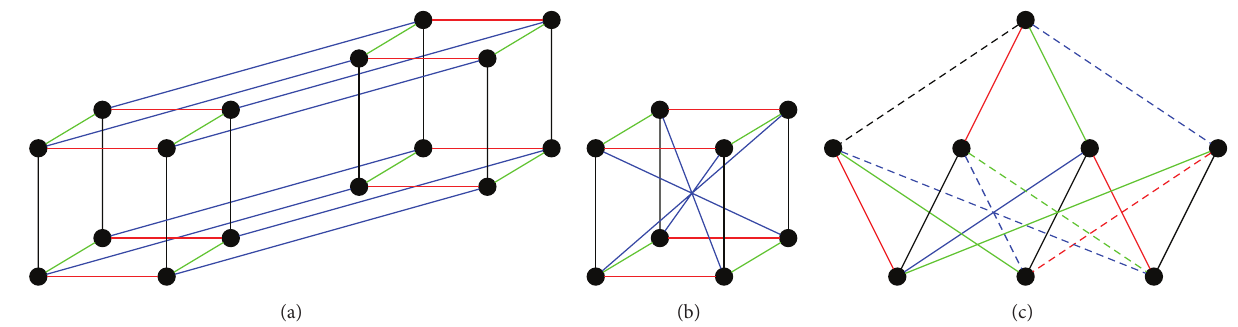
Figure 2: (a) The colored graph 𝐼 4 . (b) The quotient 𝐼 4 /{0000, 1111} . (c) As the code {0000, 1111} is doubly even, there exists an Adinkra with the quotient as its underlying graph by Theorem 3.